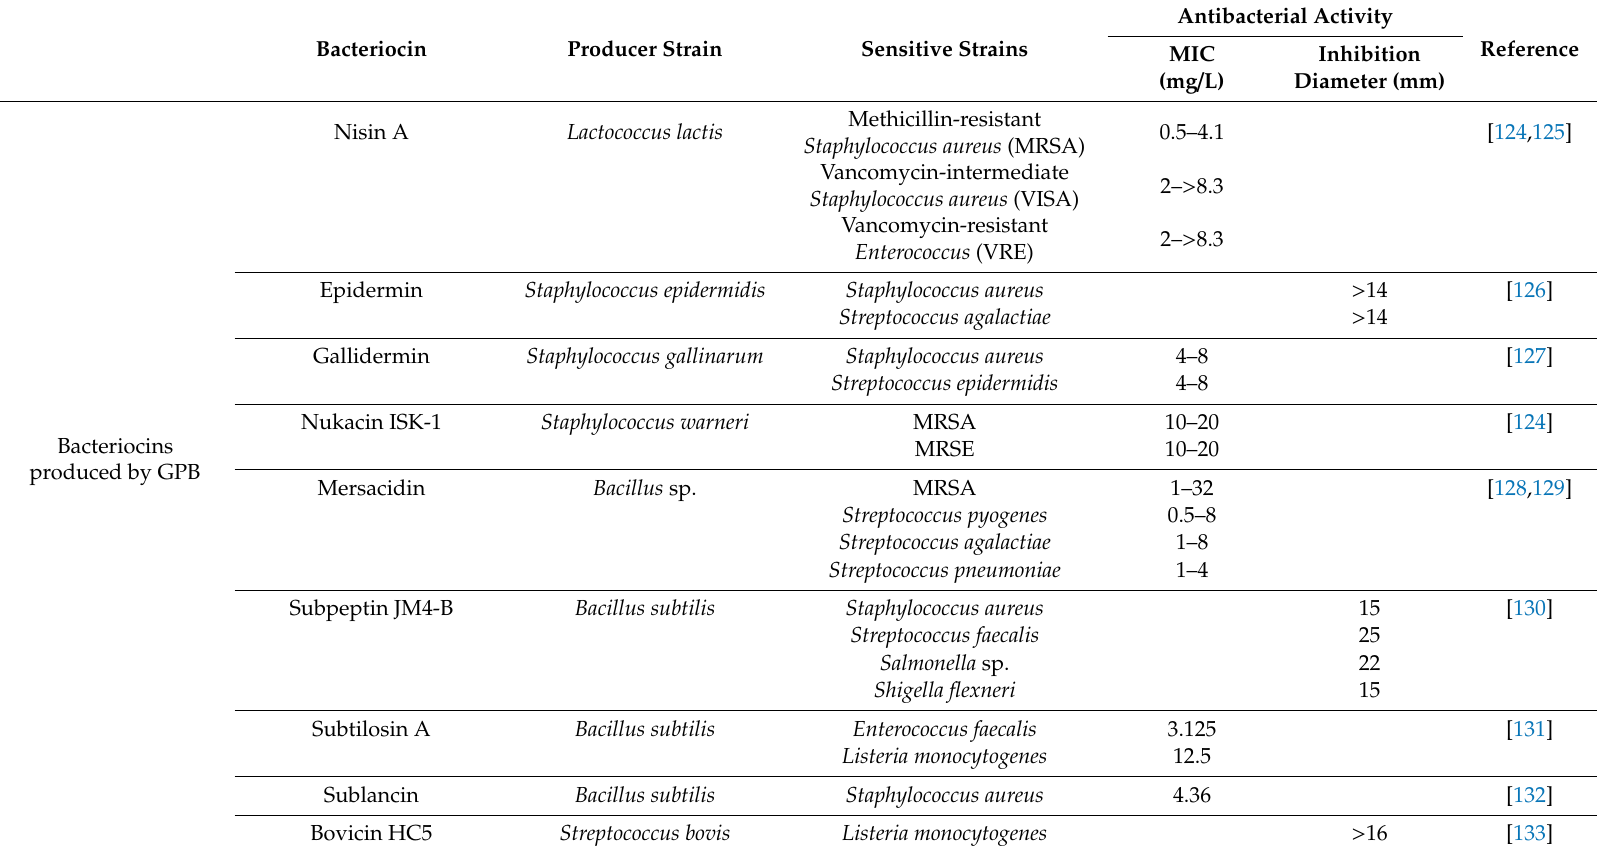
Table 1. Antibacterial activities of various bacteriocins produced by Gram-positive bacteria (GPB) and Gram-negative bacteria